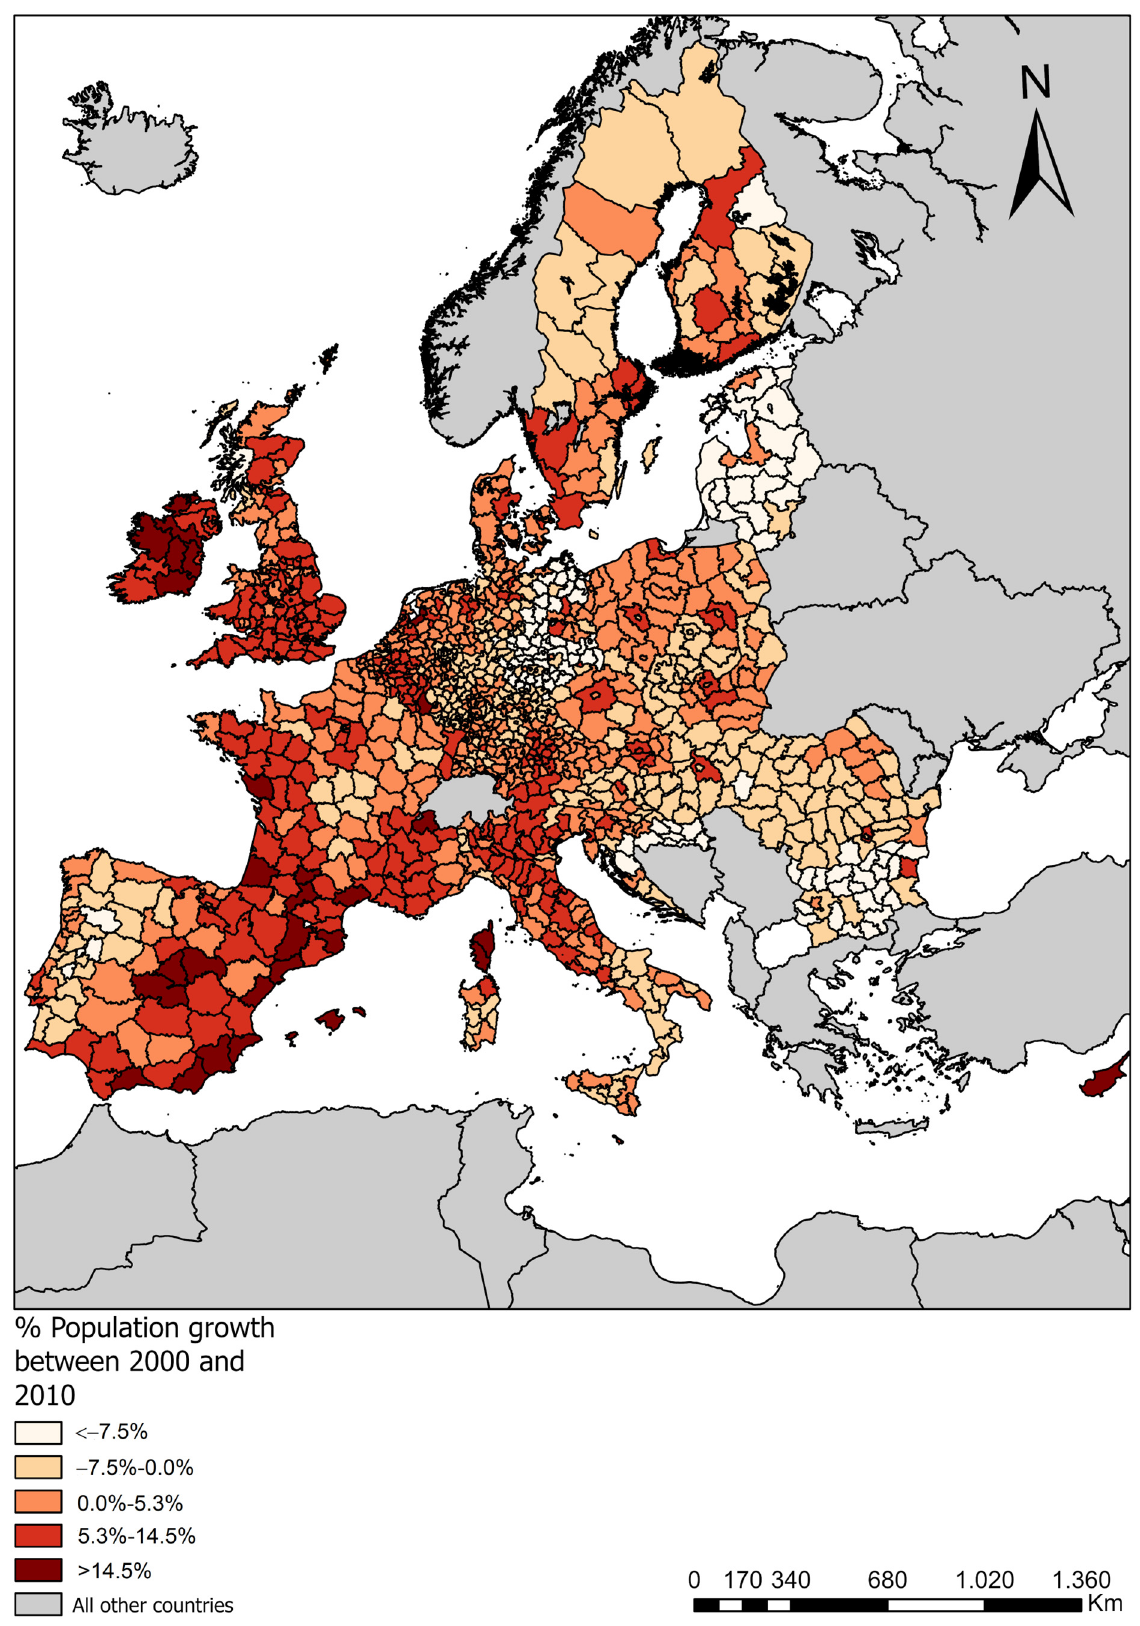
Figure 1. Percentage change in population in the EU countries at the NUTS3 level, 2000–2010.